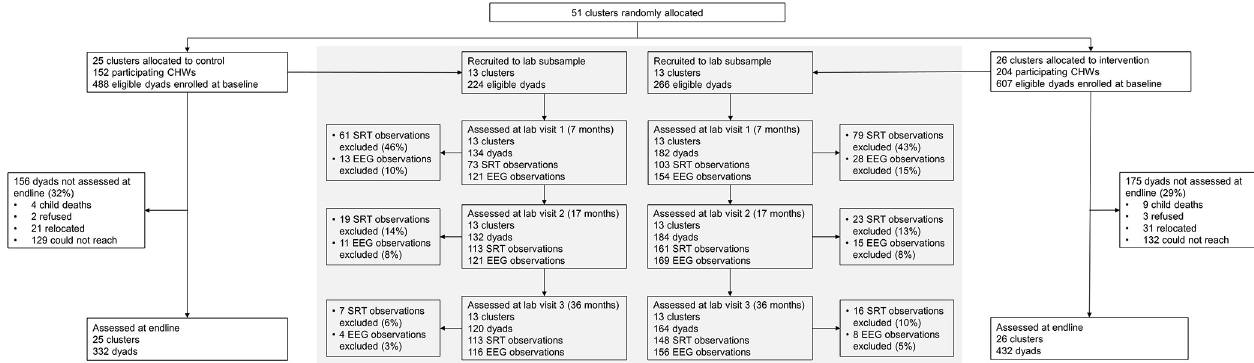
Fig 2. Trial profile. CHW AU : AnabbreviationlisthasbeencompiledforthoseusedinFig 2 : Pleaseverifythatallentriesarecorrectlyabbreviated : , community health worker; EEG, electroencephalography; SRT, saccadic reaction time.